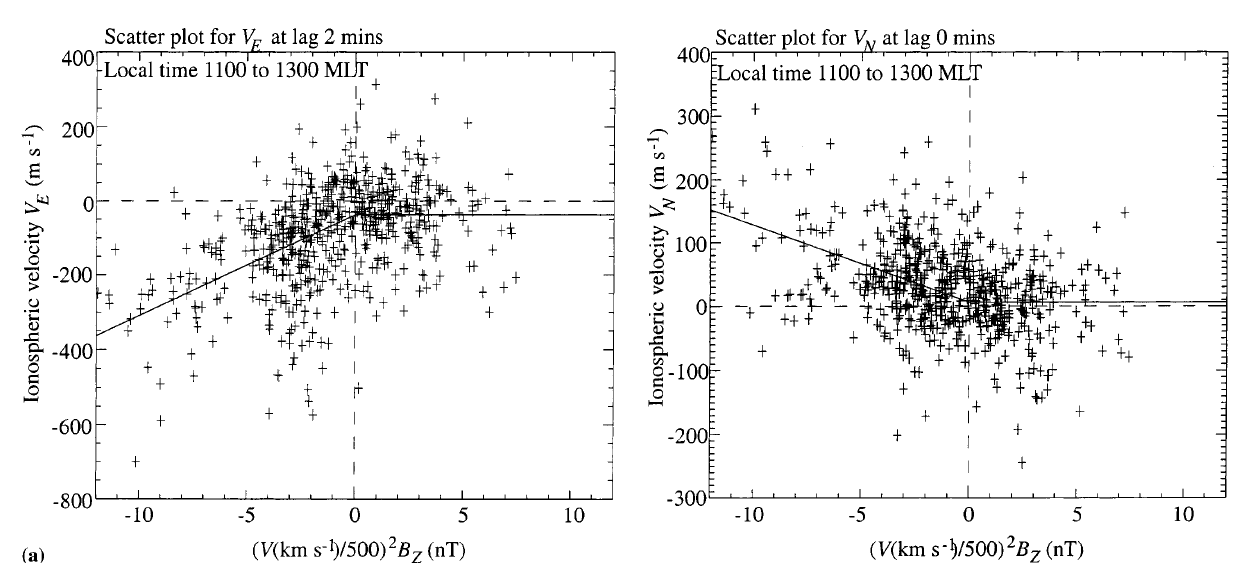
Fig. 4. a Results of the cross-correlation analysis between V 2 B the eastward ( left hand ) and northward ( right hand ) flow components for the 2-h interval of local time centred on 1200 MLT. The upper panels show the value of the cross-correlation coe(cid:129)cient versus lag in the interval (cid:139)120 min at 2 min resolution, with positive lags representing the physical scenario in which the interplanetary medium leads the ionosphere. The nearly horizontal dot-dashed lines show the